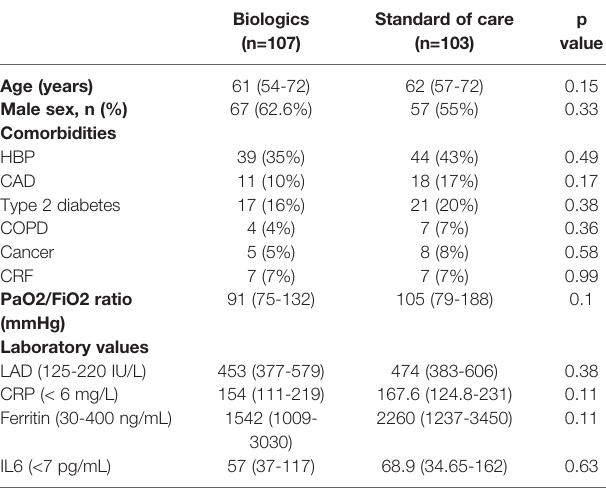
TABLE 1 | Clinical and serological features of the patient cohort.